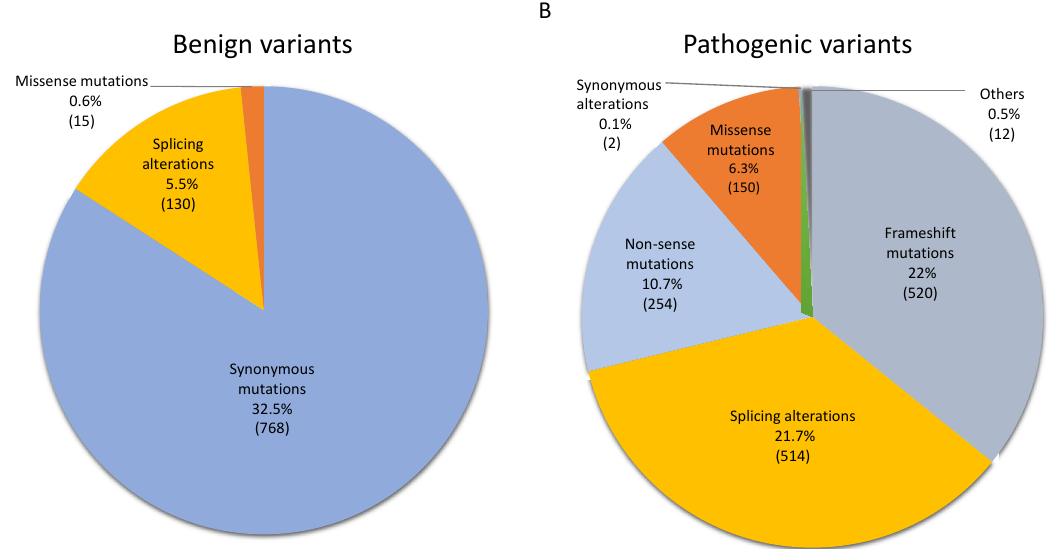
Figure 1. NF1 germinal mutational spectrum and potential pathogenicity. A total of 2365 variants were classified in different categories including missense 165 (7%), 254 non-sense (10%), 520 frameshift (22%), 644 splicing alterations (27%), 770 synonymous (32%), and 12 are annotated as others (2%). They were also classified as ( A ) benign (913, 39%) or ( B ) pathogenic (1452, 61%) based on the annotation as reported in ClinVar.